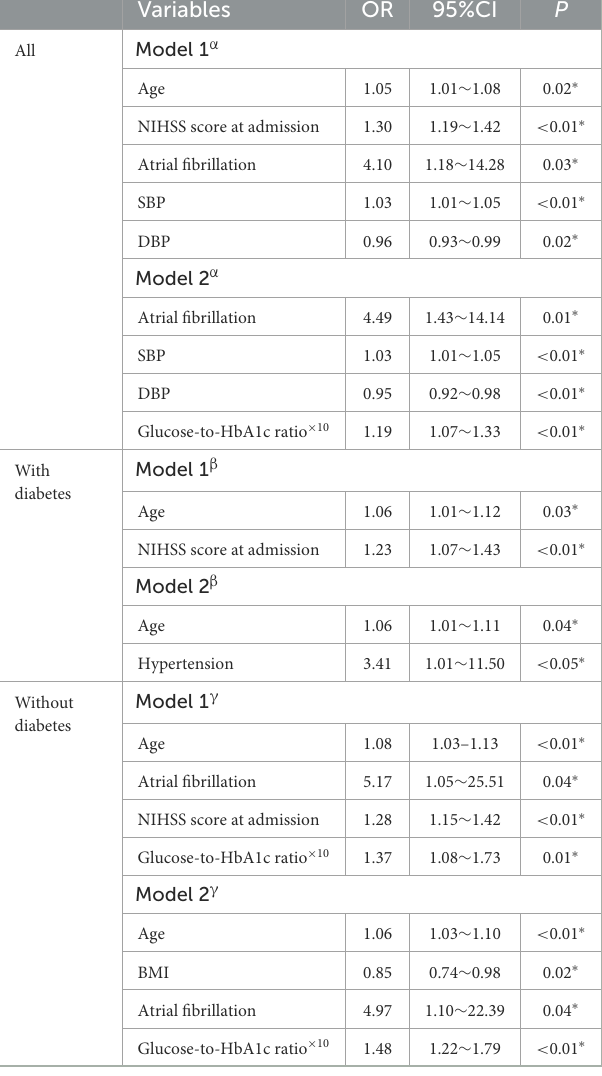
FIGURE2 Receiver operating characteristic curve showing optimized cutoff for the glucose-to-HbA1c ratio in predicting poor functional outcomes (mRS score 3–6).